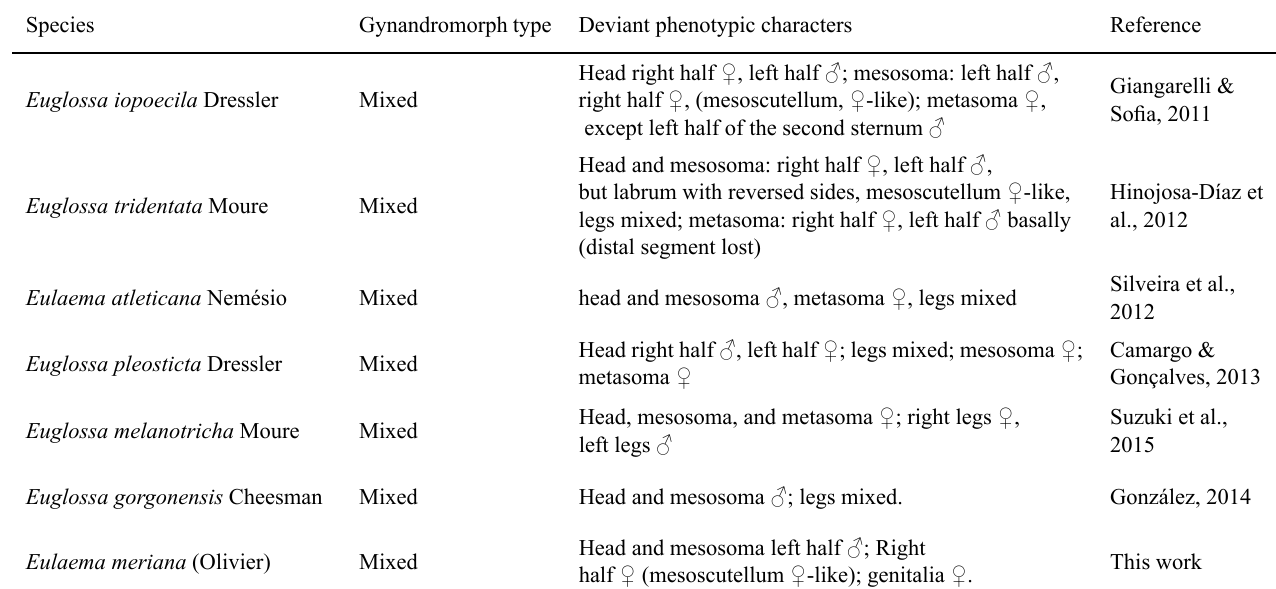
Table 1 . Comparison of characters among orchid bee gynanders recorded until